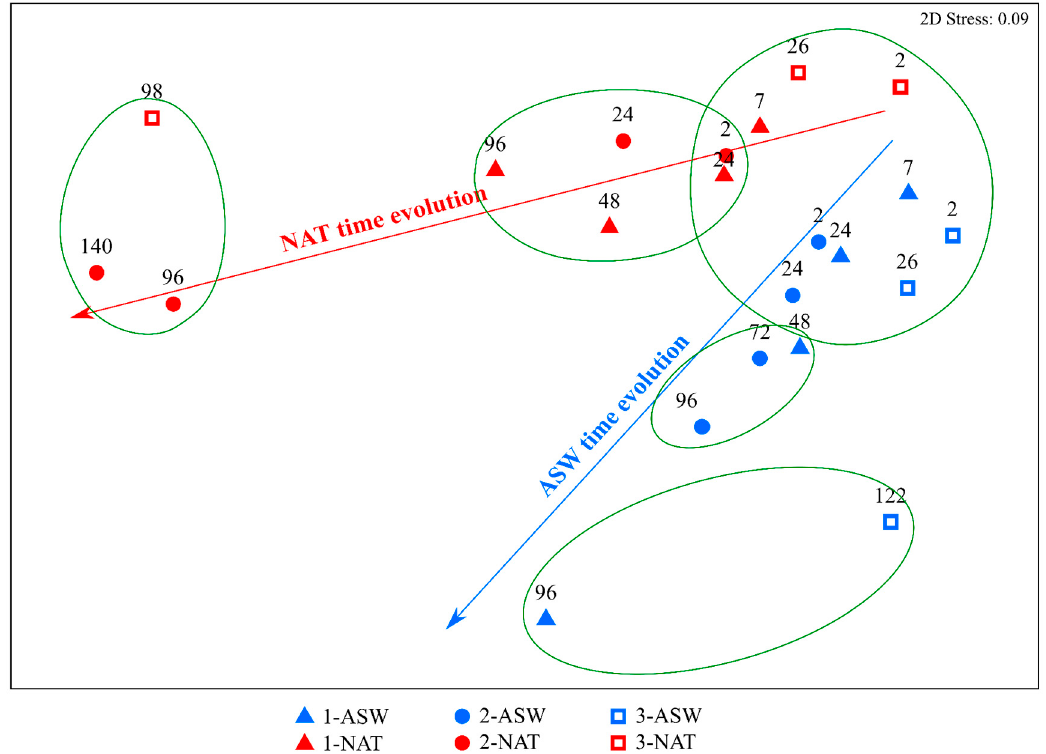
Figure 7. Nonmetric multidimensional scaling analysis (nMDS) of the T. rotula culture experiments. The first experiment (EXP-1) is represented by triangles, the second (EXP-2) by circles and the third (EXP-3) by squares. Blue symbols represent the artificial seawater medium (ASW), and red symbolises the natural seawater medium (NAT). Numbers above the symbols represent the sampling time (h). The green lines represent the groups identified by the similarity profile (SIMPROF) analysis.